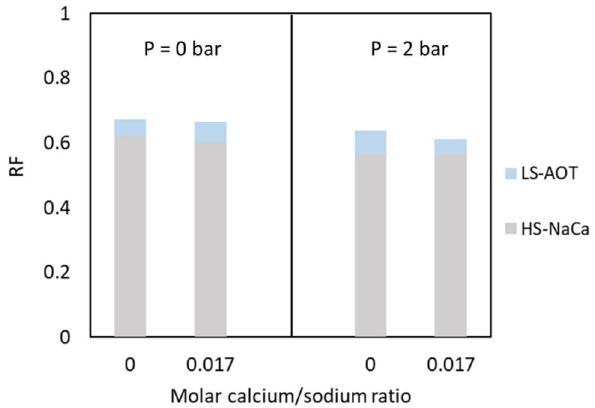
Figure 4. Average RF for crude oil A aged for 2 h and displaced first by HS-NaCa and then LS-AOT with and without calcium at 22 °C. Standard deviations for the measurements are within 10% error margin in all cases.